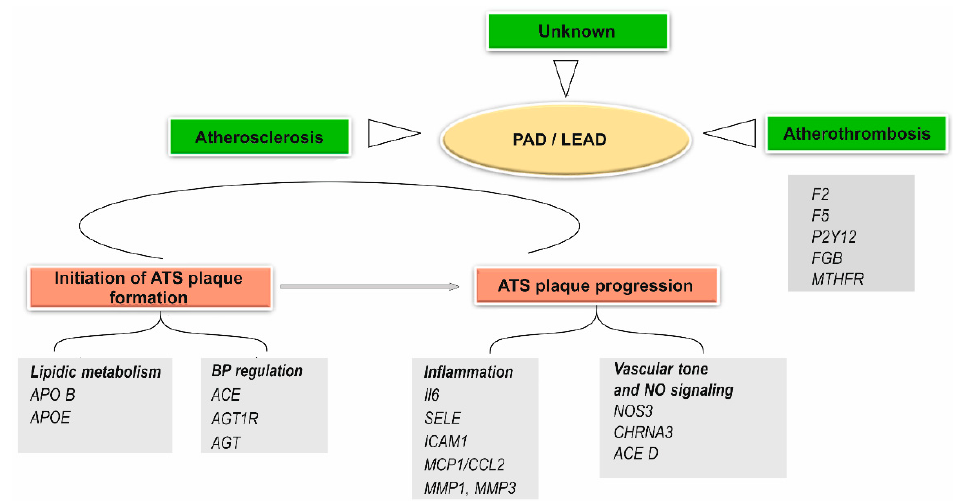
Figure 2. The Main Genes Involved in the Pathophysiological Mechanism of LEAD [13,17,22]. ATS plaque: atherosclerotic plaque; BP: blood pressure.